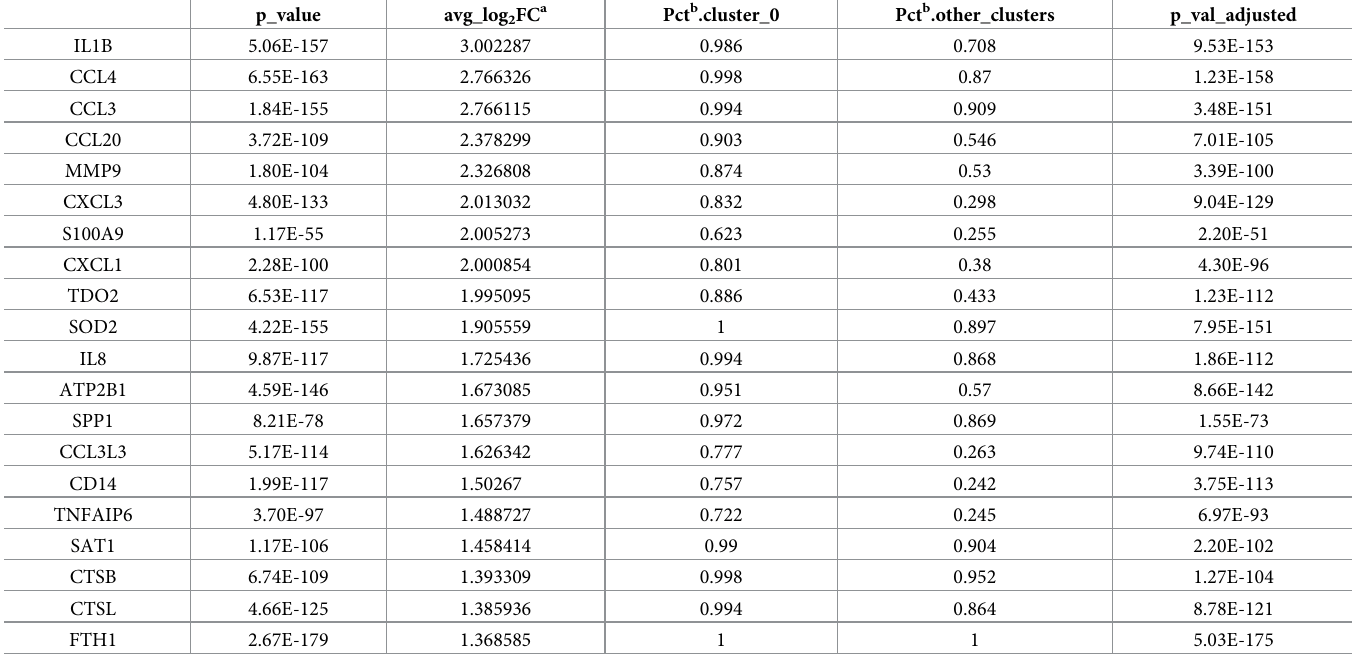
Table 1. Top 20 genes with upregulated expression in cluster 0 compared to other clusters among the infection